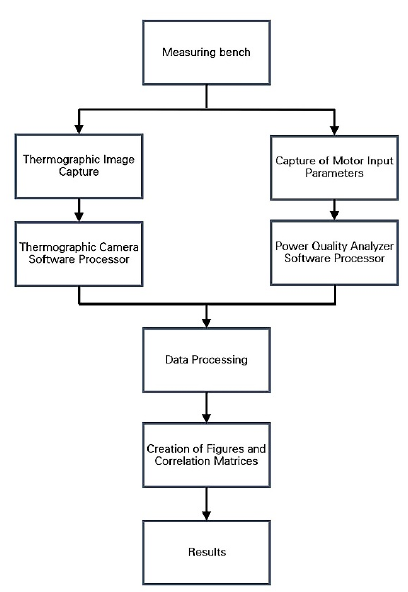
Figure 6. Flowchart of the methodology used to obtain the results from the measurements.